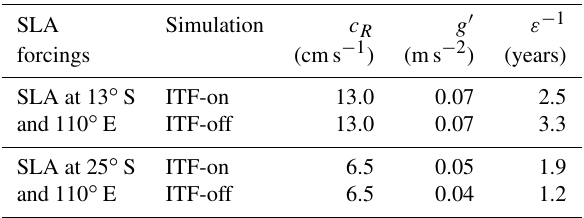
Table 1. Summary of the parameters used in the RG model. SLA Simulation c R g (cid:48)